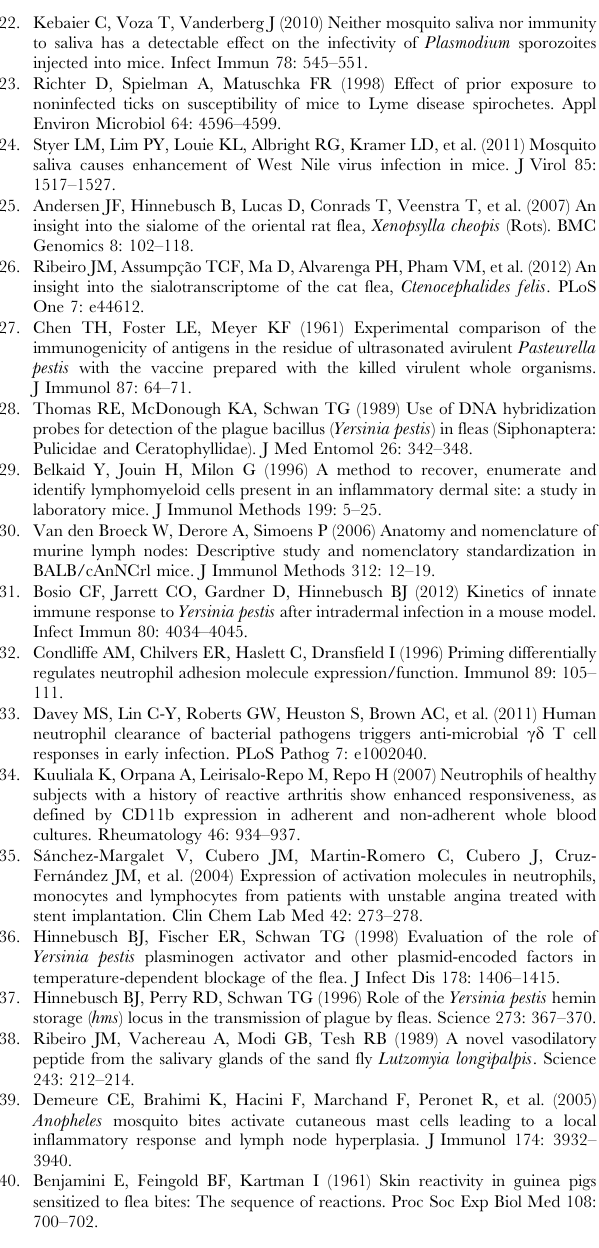
Figure S1 Histological changes in skin of flea-exposed Balb/c mice 3 days after flea bites. Representative examples of skin showing minimal inflammation ( A , score= 1), and mild inflammation ( B , score= 2); ( C ), unbitten control skin (score =0). 2/5 and 3/5 ear samples had a score of 1 or 2, respectively. Mice were exposed to 20 fleas once per week for 10 weeks. Mean number of total flea bites per mouse 6 s.d.= 101 6 21. Scale bars =50 um. (TIF) Table S1 Serum antibody responses to salivary gland extract in a group of 5 Balb/c mice exposed to 20 fleas 1 6 /week for 10 weeks.